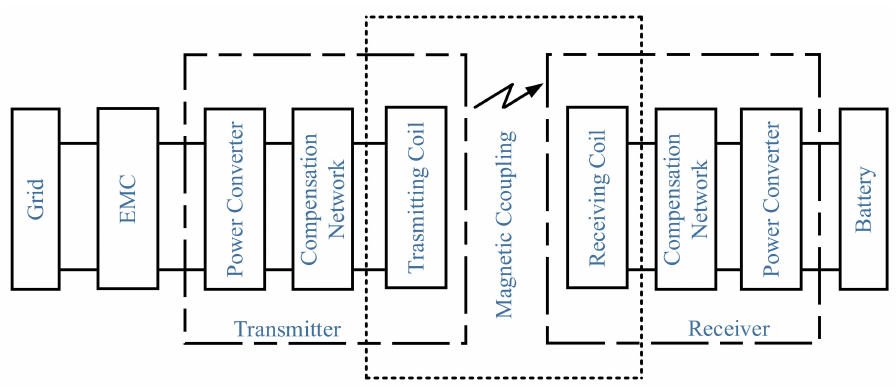
Figure 1. General schematic of the WPT